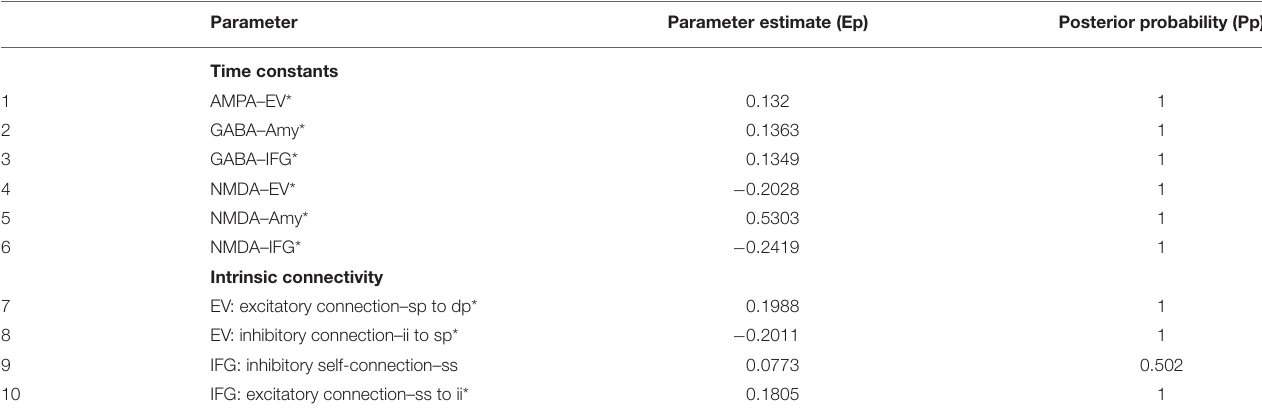
TABLE 2 | Drug effects over